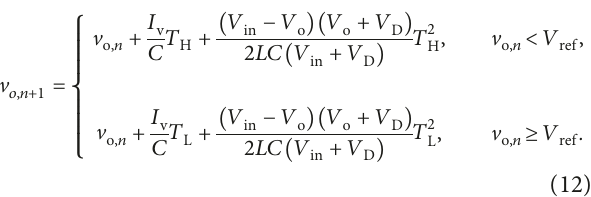
Figure 2: Capacitor current of the DCPT-controlled buck